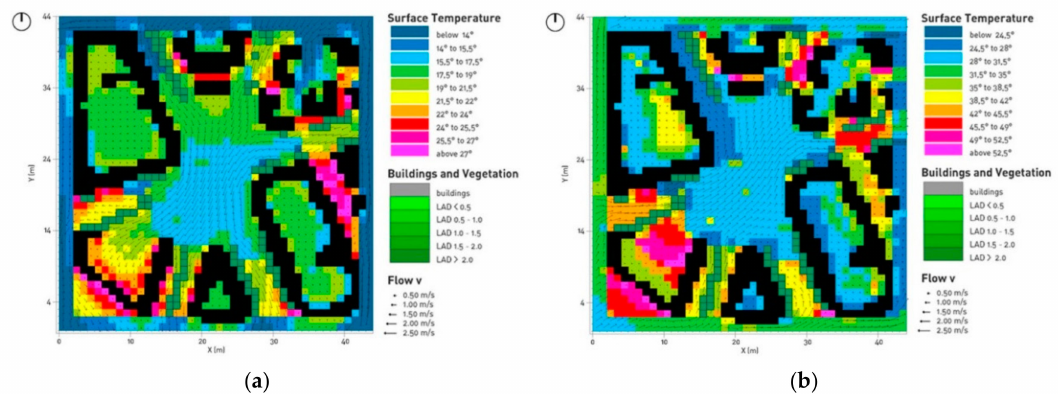
Figure 9. Scenario 1 surface temperature and wind speed analysis: ( a ) Winter analysis based on 21st December at 3:00 p.m.; ( b ) Summer analysis based on 21st June at 3:00 p.m. (analysis software: ENVI-met